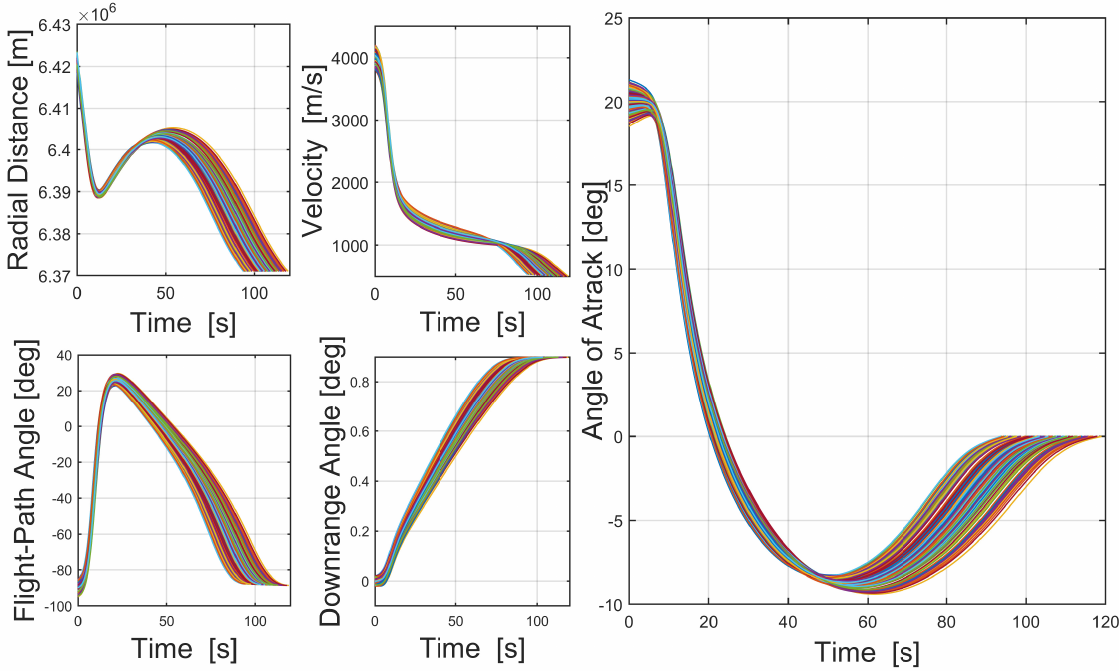
Figure 2. Training dataset of HVR problem.